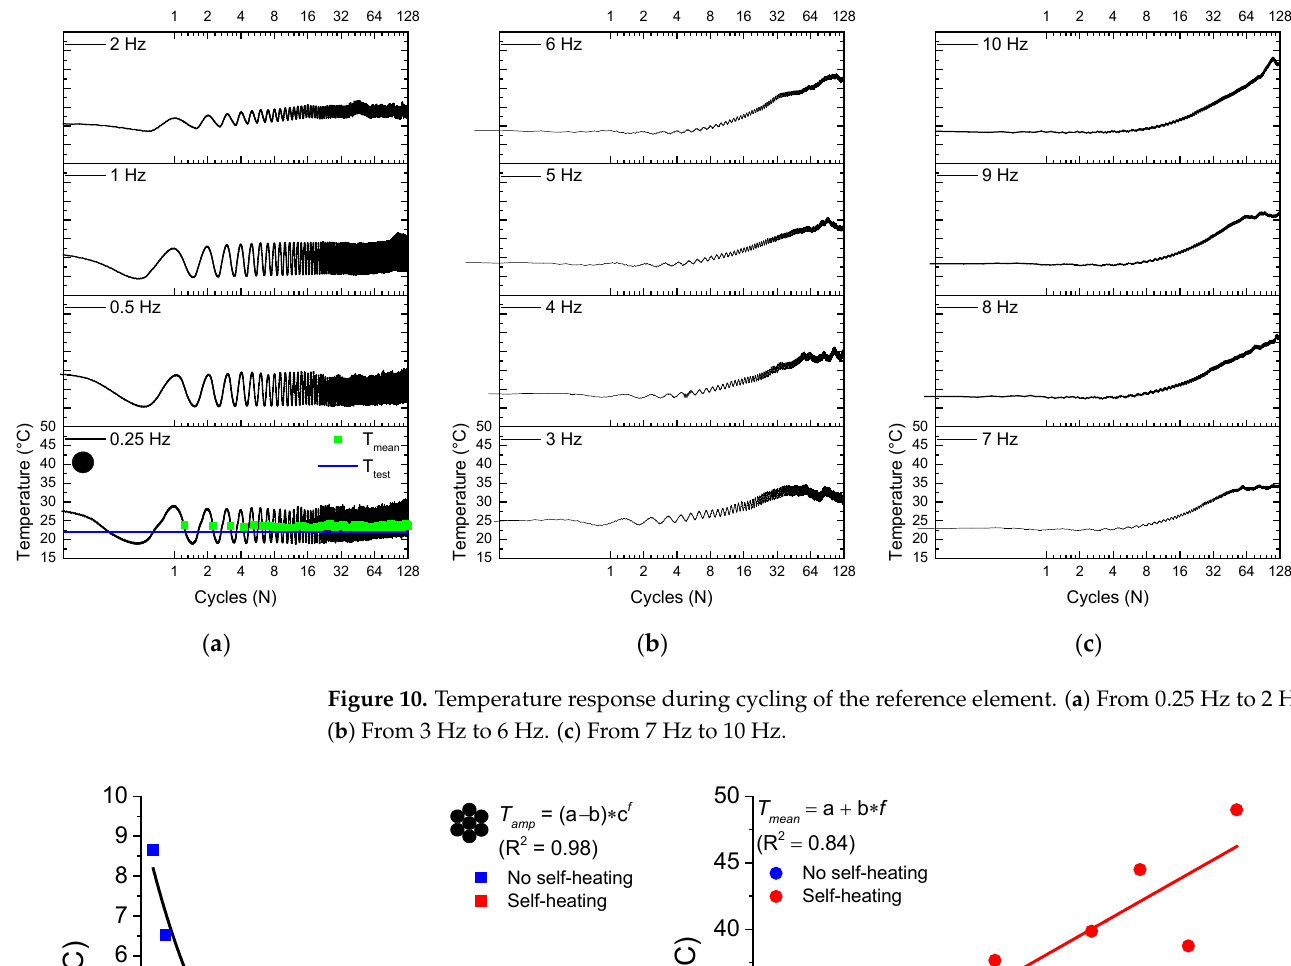
Figure 10. Temperature response during cycling of the reference element. ( a ) From 0.25 Hz to 2 Hz. ( b ) From 3 Hz to 6 Hz. ( c ) From 7 Hz to 10 Hz.